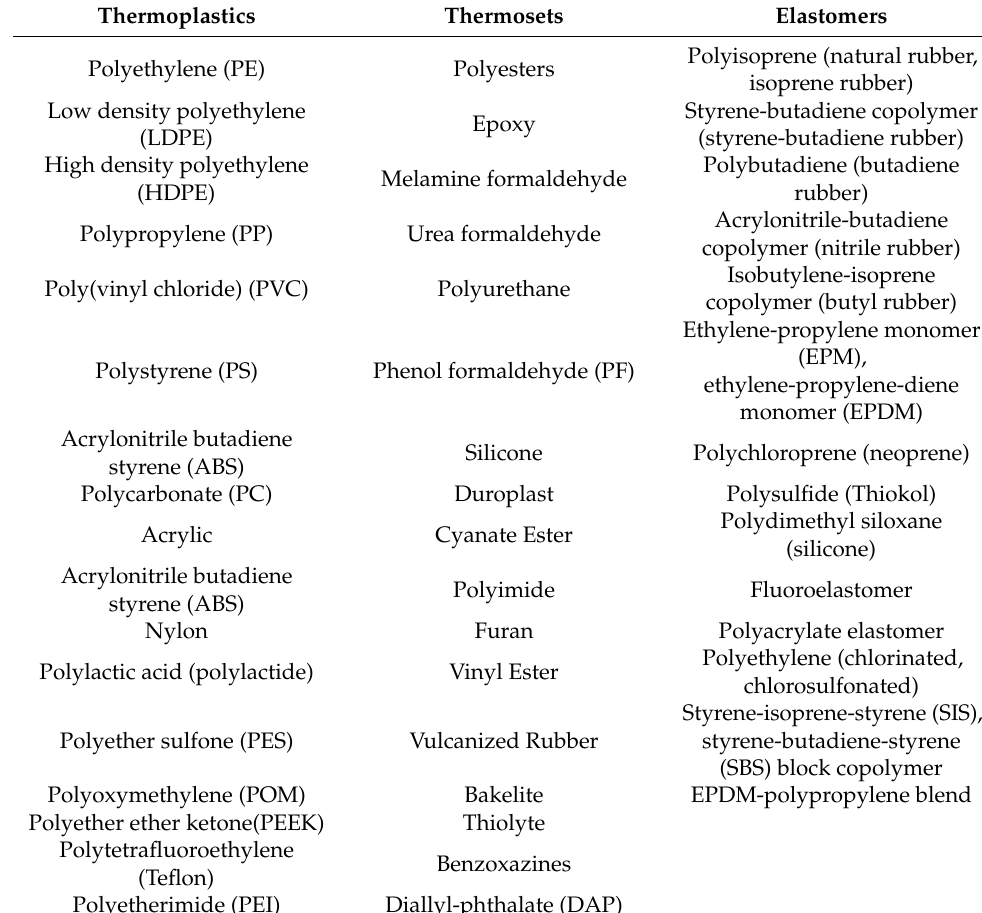
Table 1. Classification of the most common polymeric materials of commercial interest for the construction of heat transfer